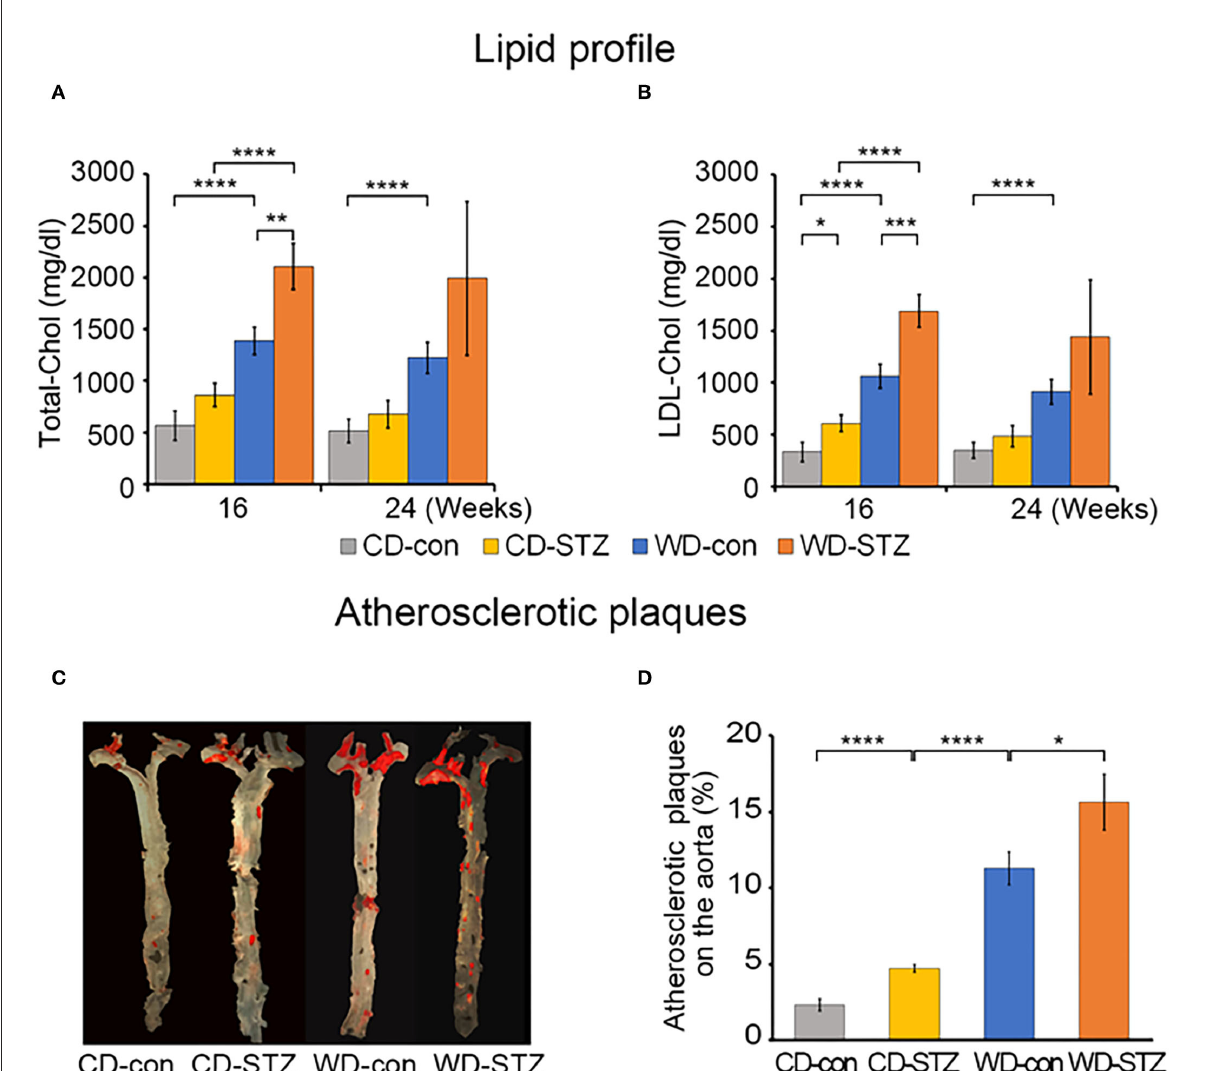
FIGURE2 Lipid profiles and atherosclerotic plaques. (A) The plasma total cholesterol level in each group of mice at 16 and 24 weeks of age. (B) Low-density lipoprotein (LDL) cholesterol in each group of mice at 16 and 24 weeks of age. (C) Representative en face images of the atherosclerotic plaques in the whole aorta using Sudan IV staining (red). (D) Percentage of lesion areas relative to the whole aortic area in CD-con, CD-STZ, WD-con, and WD-STZ ApoE KO male mice at 24 weeks of age. * p < 0.05, ** p < 0.01, *** p < 0.001, and **** p < 0.0001.